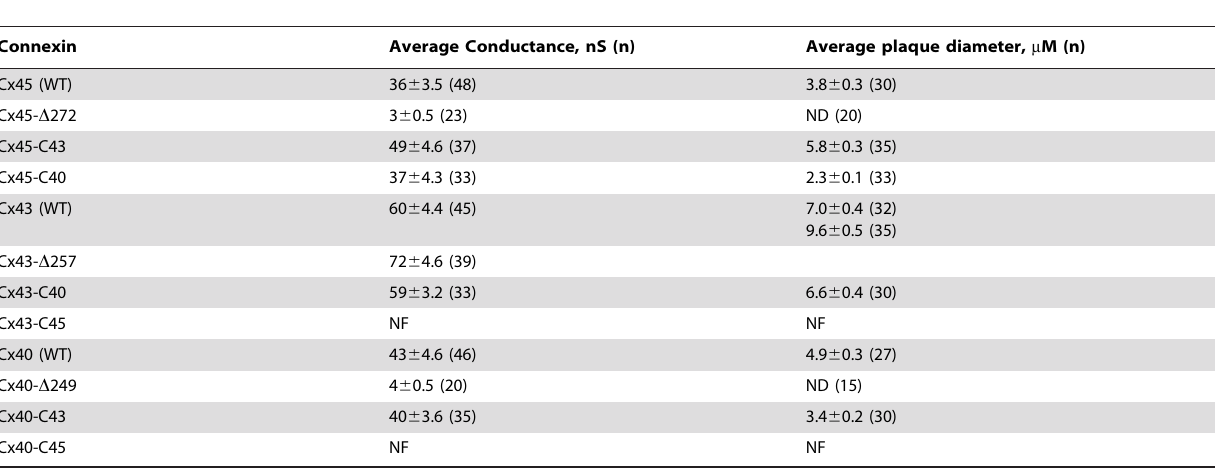
Table 1. Average conductance and junctional plaque diameter of different